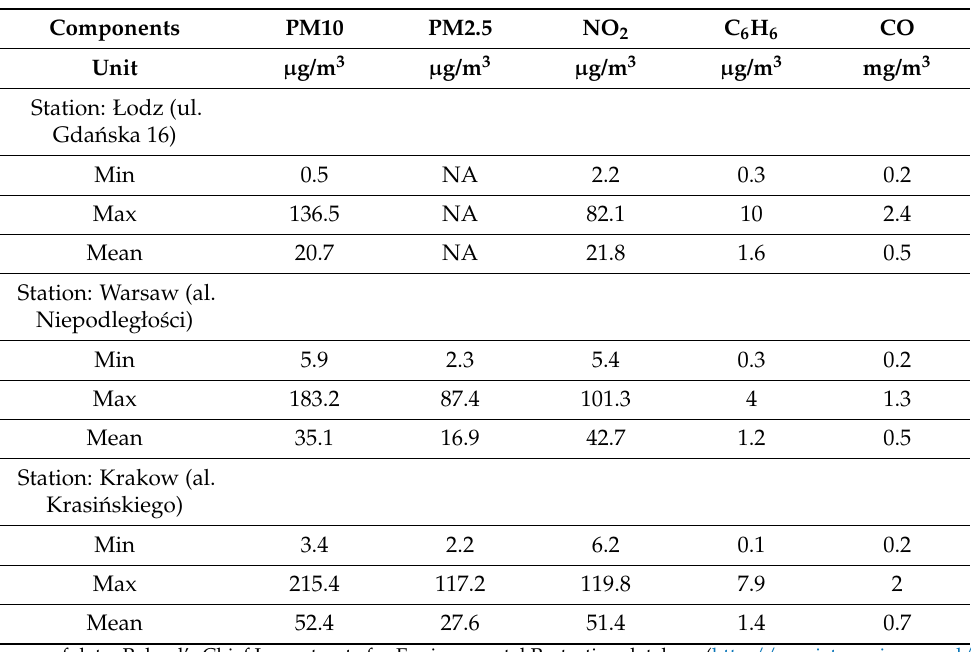
Table 7. Geo-spatial data analysis from selected Polish government pollution measurements (8 February 2022–9 March 2022).